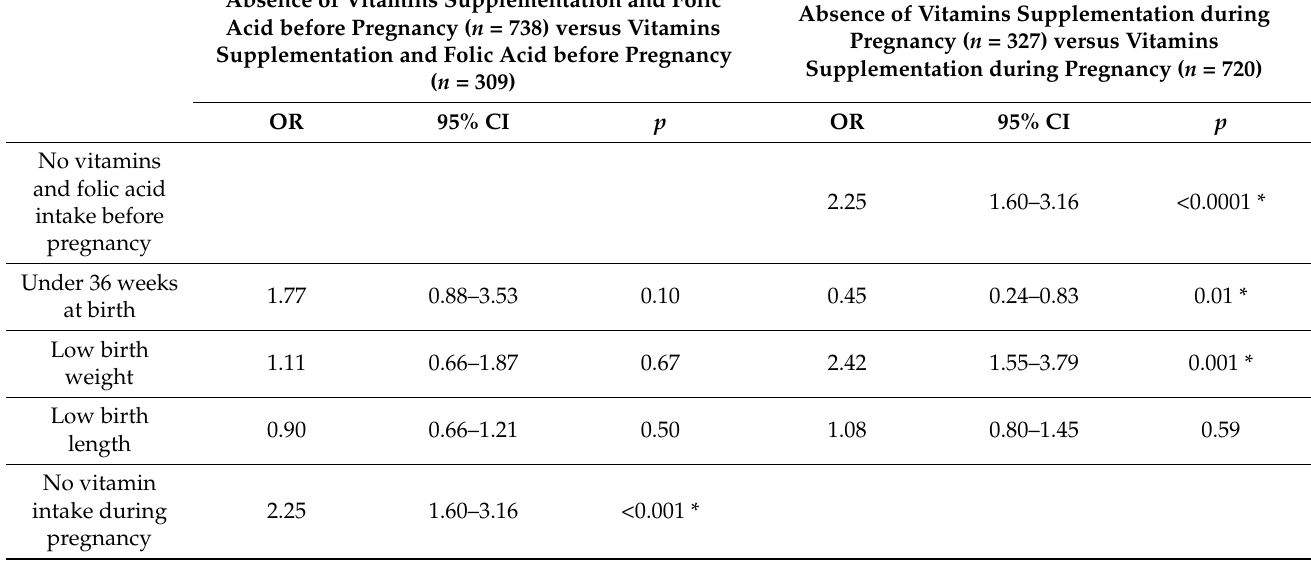
Table 9. Logistic regression model for the association of supplements intake in pre-pregnancy and pregnancy